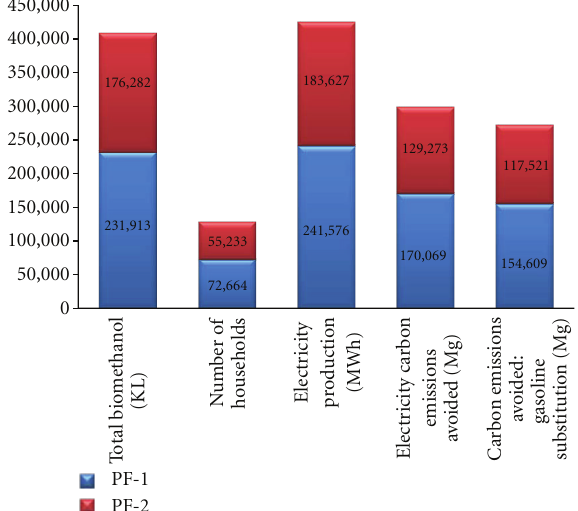
Figure 6: The amount of biomethanol produced and the amount of fossil-resource-derived electricity and gasoline, this amount can potentially replace and avoid carbon emissions when converting 100% of the annually available biomass collected from certified plantation production forests (PF).